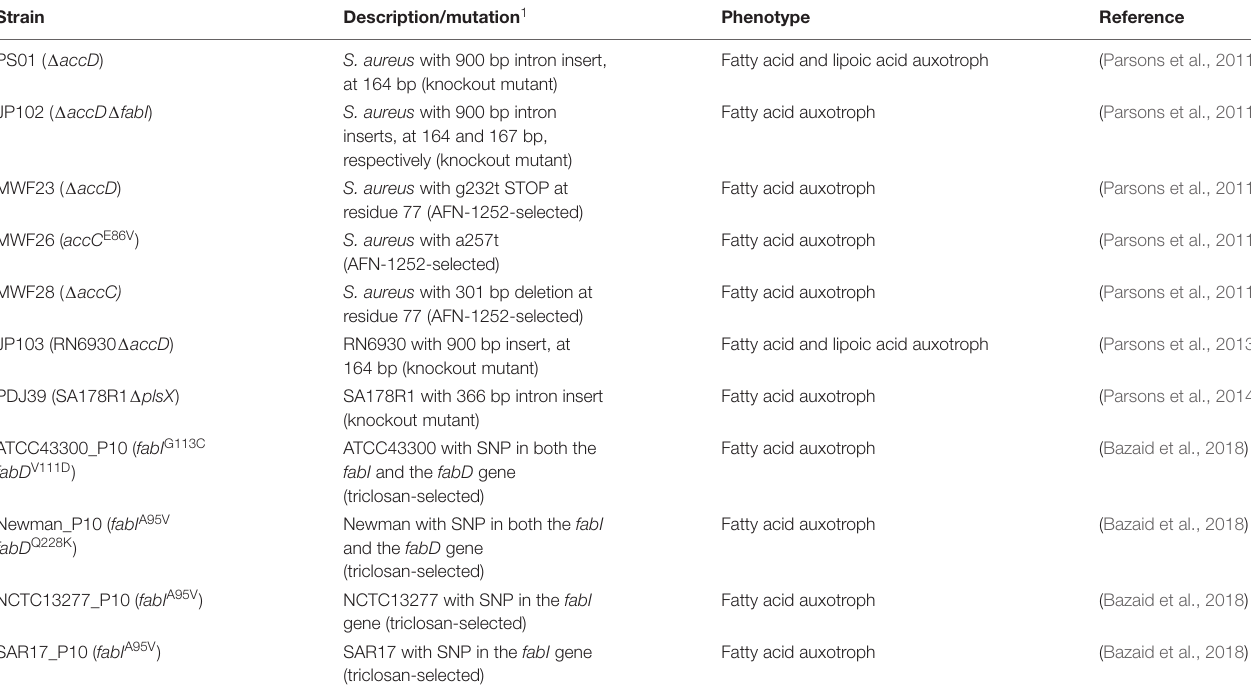
TABLE 5 | Genetically defined and FabI inhibitor selected strains with defects in fatty acid incorporation or biosynthesis (FASII).